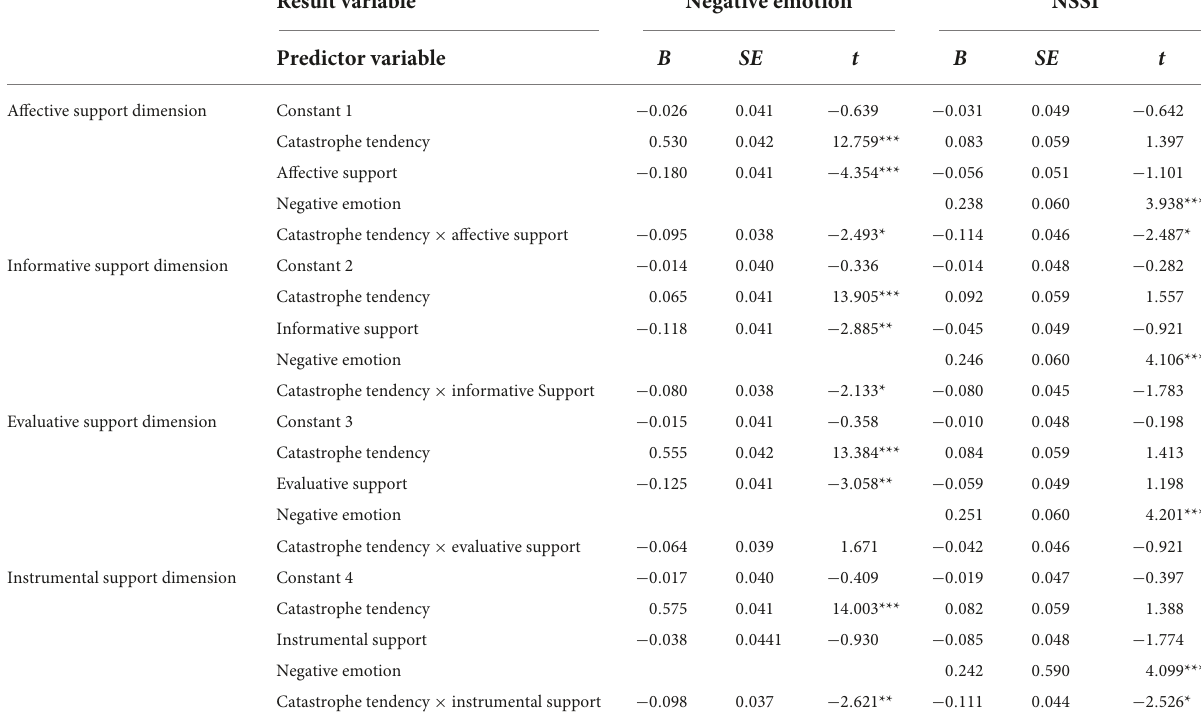
TABLE 4 Mediation model test of parental support on four sub-dimensions ( N = 401).